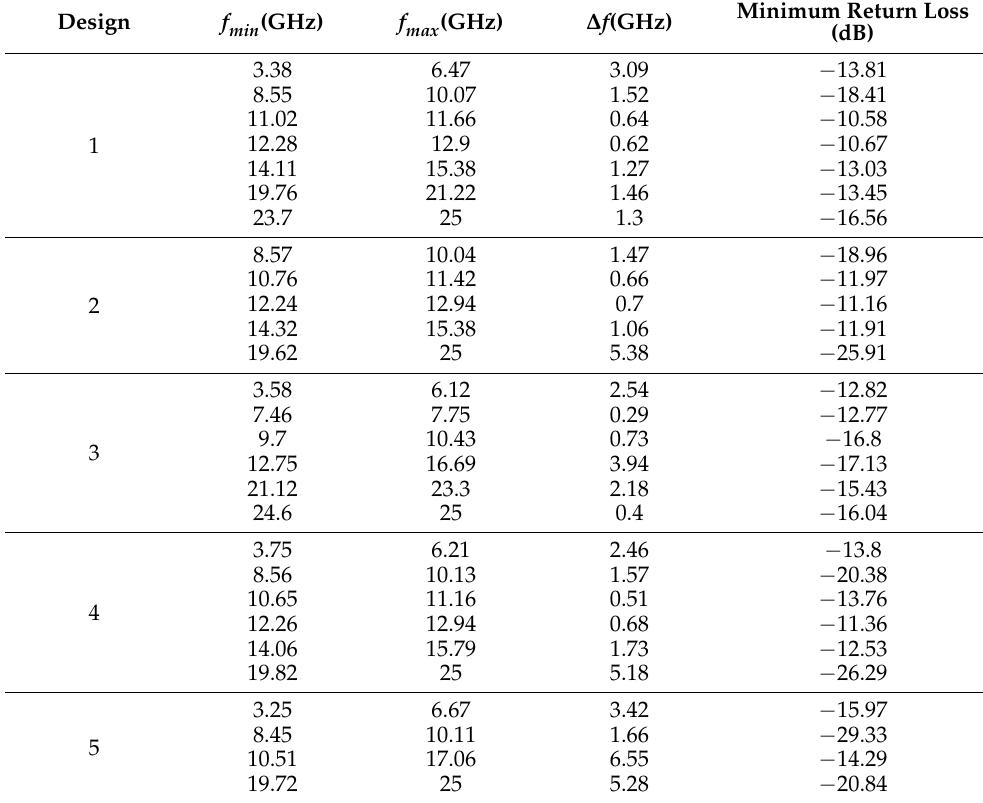
Table 3. The comparative study of achieved simulation results of frequency band and minimum return loss for the proposed